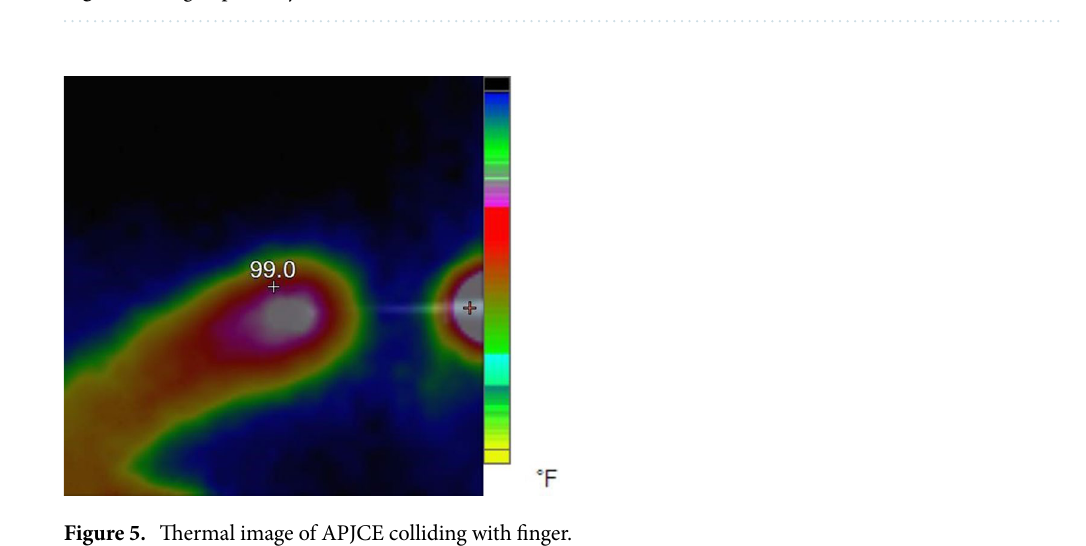
Figure 4. Argon plasma jet with APJCE structure.